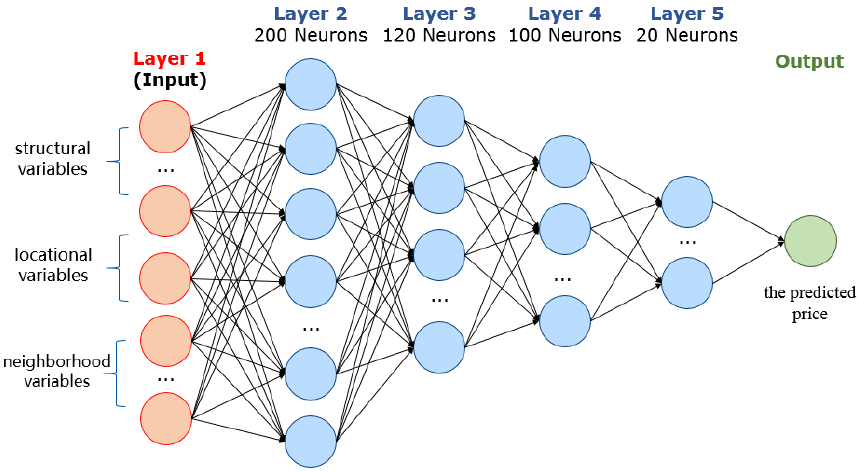
Figure 2. The structure of the layers and neurons in the FCNN model.